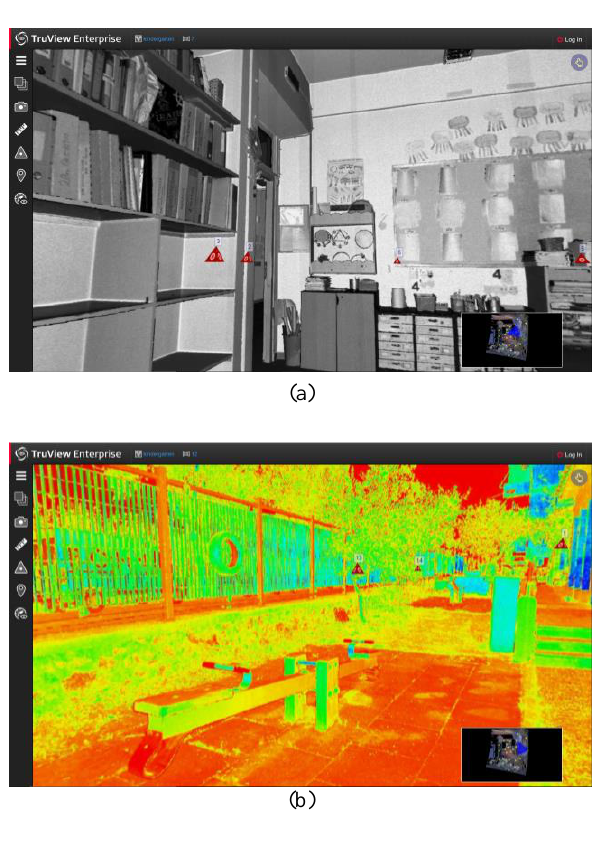
Fig. 6. Views of the model within TruView (a) indoor area (intensity grayscale) (b) outdoor area